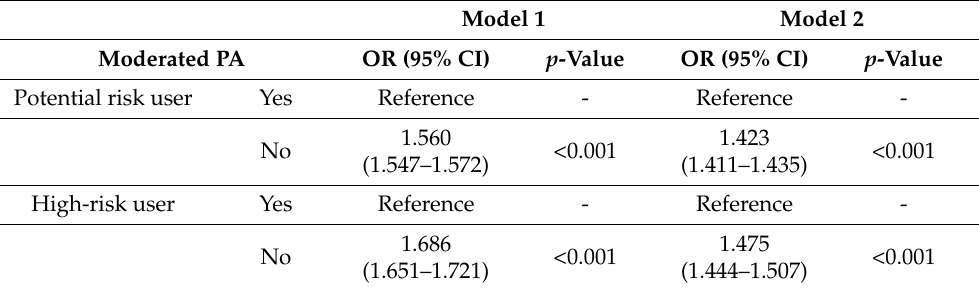
Table 3. Logistic regression analysis on level of smartphone addiction based on moderate PA.